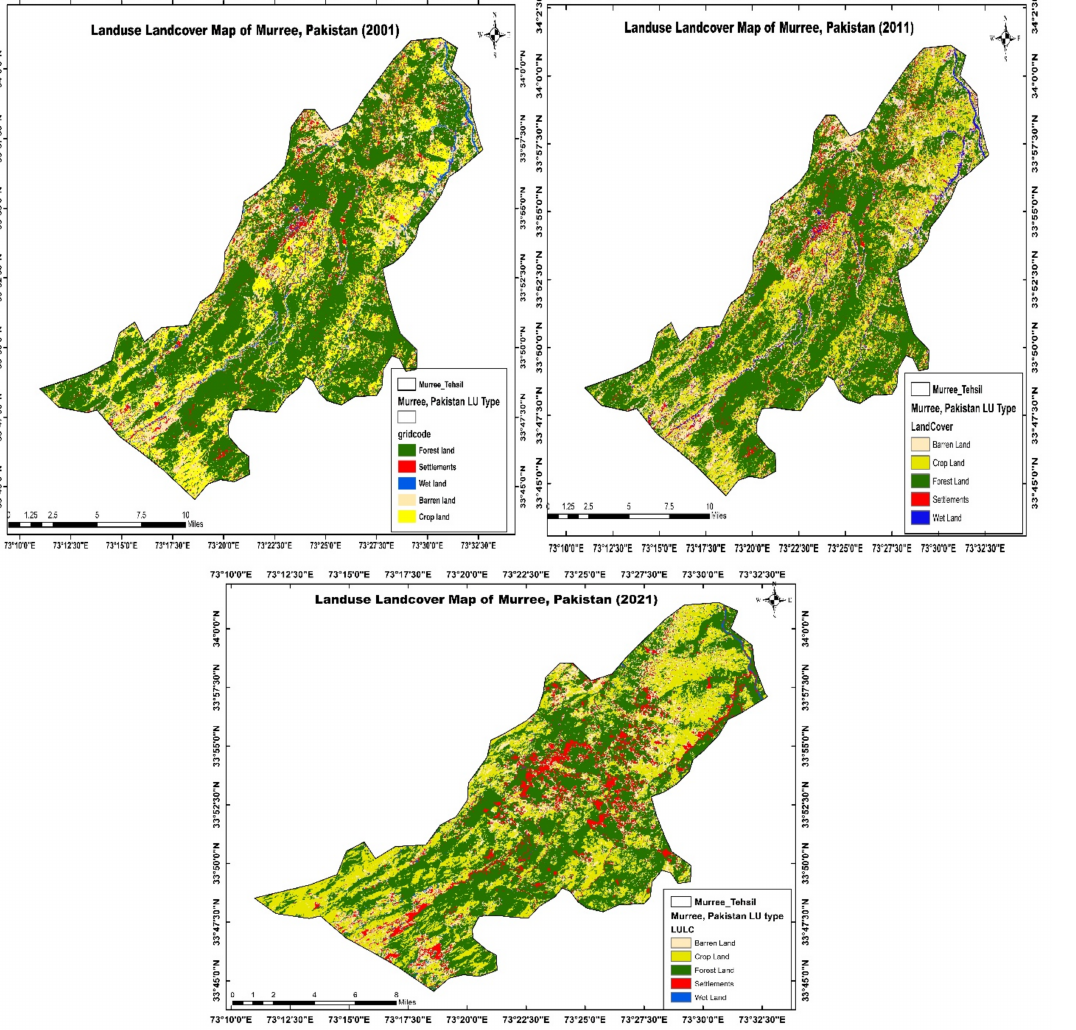
Figure 4. LULC map of Murree, showing five land-use land-cover (LULC) classes (2001, 2011 and